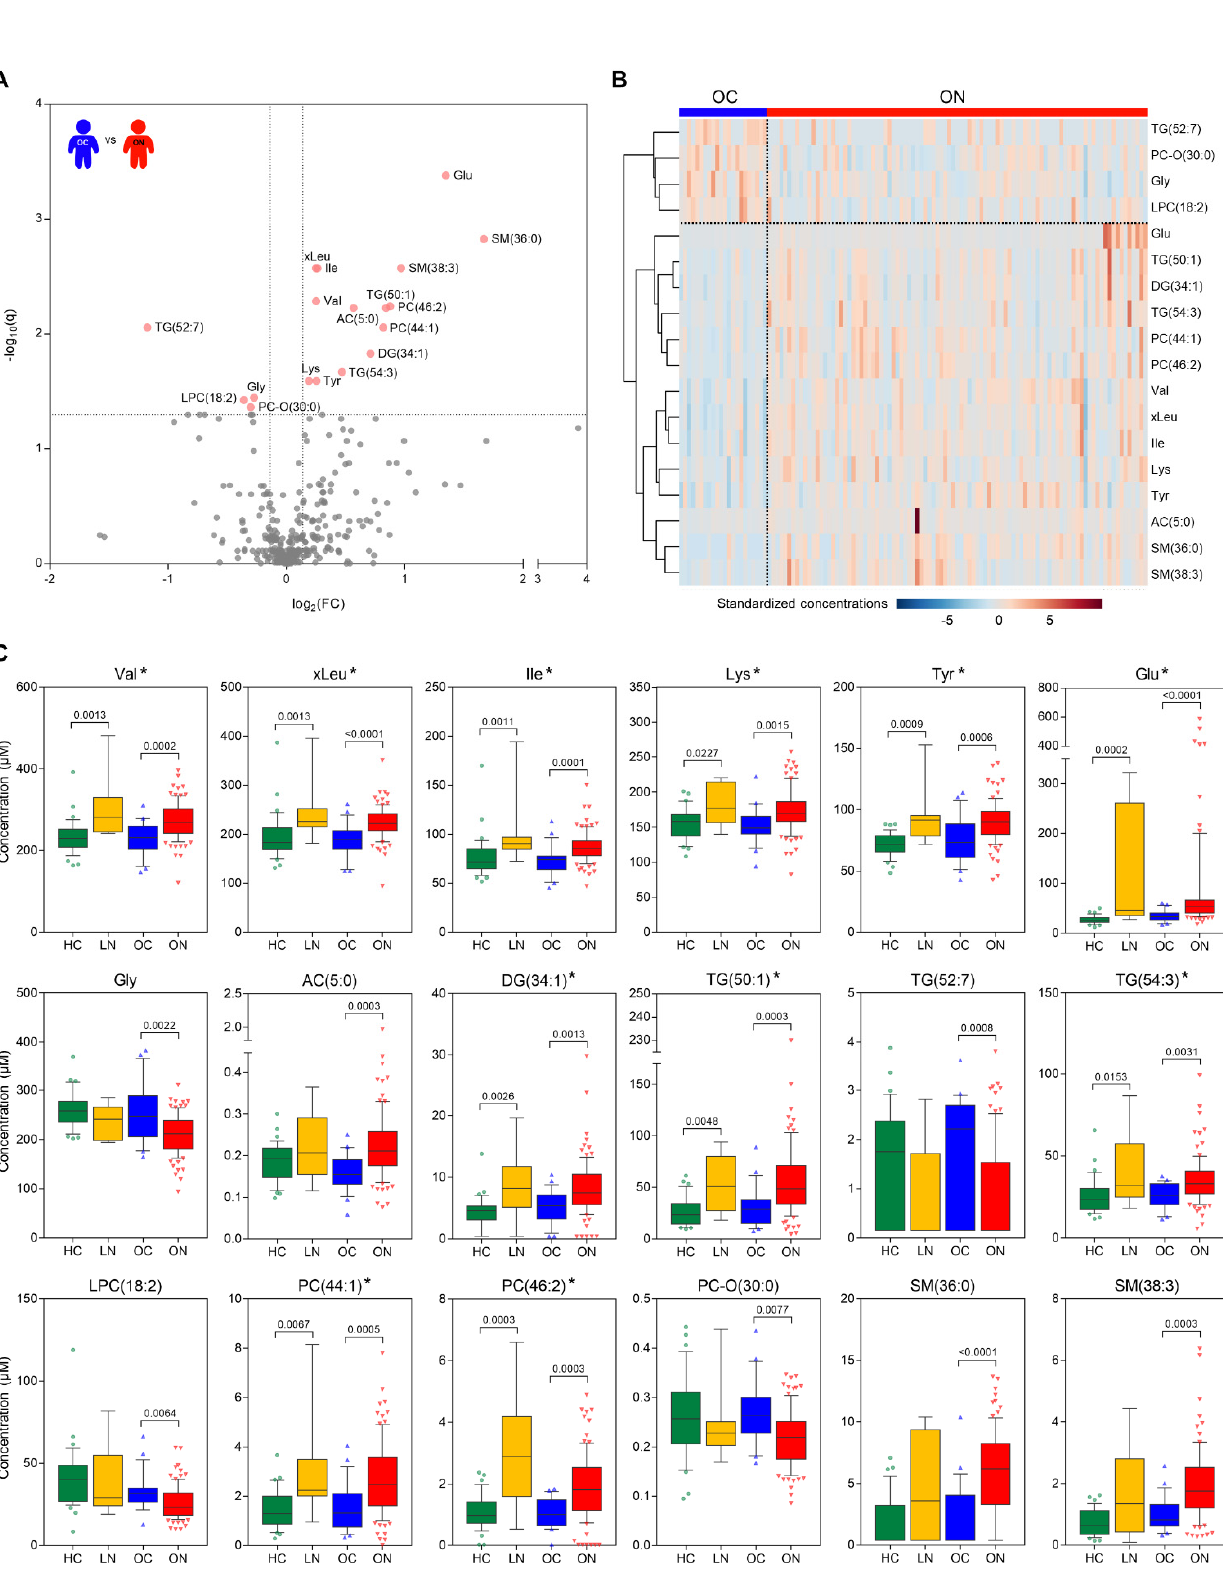
Figure 2. Metabolic features of overweight NAFLD (ON) compared to those of overweight control (OC). ( A ) A volcano plot and ( B ) a heat map of significant plasma metabolites (NAFLD-specific metabolic features, FDR adjusted p -value < 0.05 by Wilcoxon rank-sum test, fold change > 1.1) between OC and ON groups. In the volcano plot, significant metabolites are labeled with coral red. In the heat map, concentrations of each metabolite were standardized by the autoscaling of features, followed by metabolite clustering using the Ward method with Euclidean distance. ( C ) Concentrations of NAFLD-specific metabolic features in four groups. The box-and-whiskers plots show the